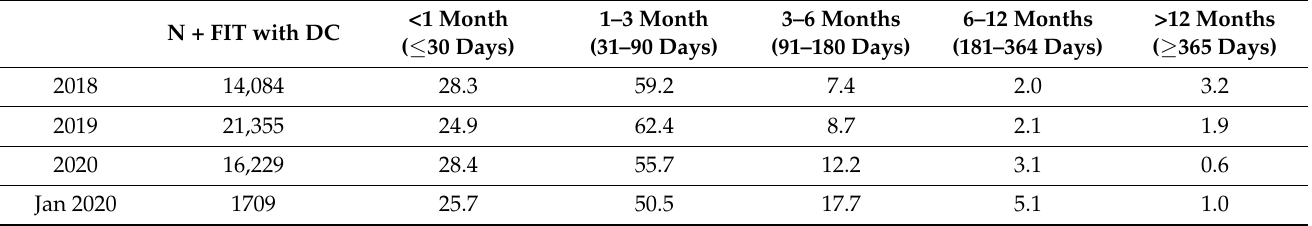
Table 7. Median time between positive FIT and DC: %